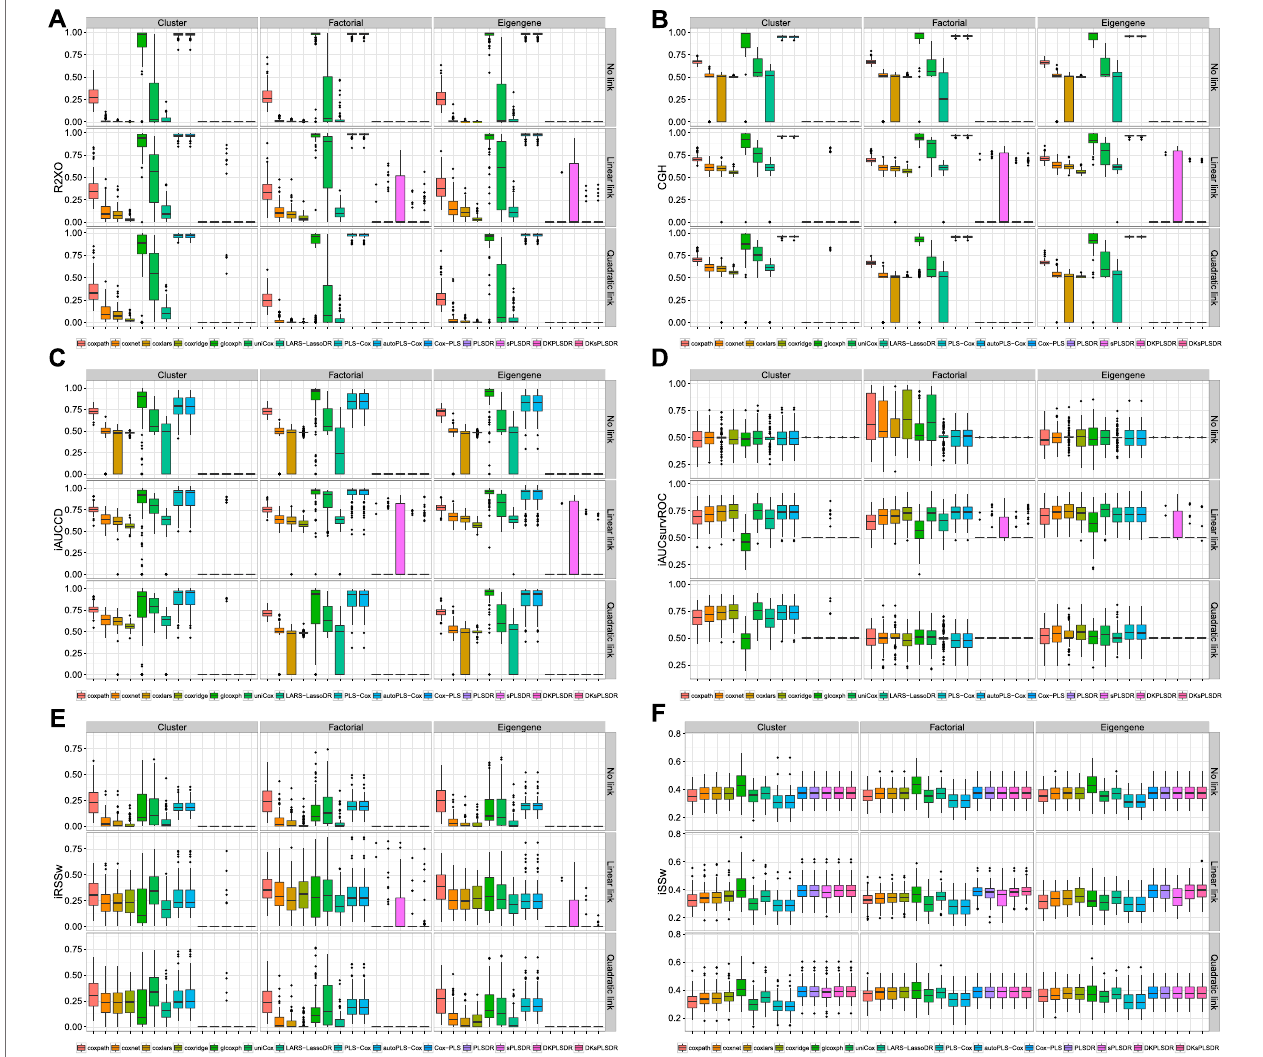
FIGURE 4 | Panel by performance measure for models when fi tted with vHCVLL cross validation panel (A) : R2XO measure. panel (B) : GHCI measure. panel (C) : iAUCCD measure. panel (D) : iAUCSurvROC measure, panel (E) : iRSSw measure. panel (F) : iSSw measure.